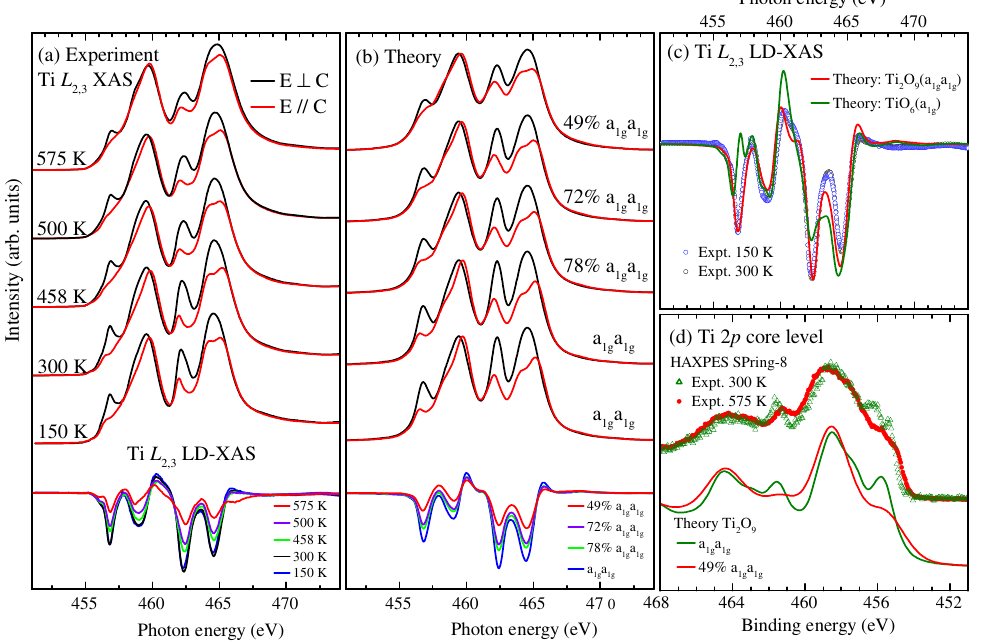
FIG. 3. Panel (a): Experimental polarization-dependent Ti- L 2 XAS spectra of Ti 2 O 3 taken at 150 K, 300 K, 458 K, 500 K, and ; 3 575 K. Panel (b): Calculated polarization-dependent Ti- L 2 XAS spectra for the corresponding temperatures using the Ti 2 O 9 ; 3 cluster. In the bottom of panels (a) and (b) are the corresponding linear dichroic (LD) spectra. Panel (c): Close-up of the experimental LD spectrum in the low-temperature phase (blue and black circles) and the simulation using the TiO 6 (green line: a 1 a 1 and the Ti 2 O 9 (red line: a 1 ) clusters. Panel (d): Temperature dependence of the Ti 2 p core-level spectrum and the simulations g g using the Ti 2 O 9